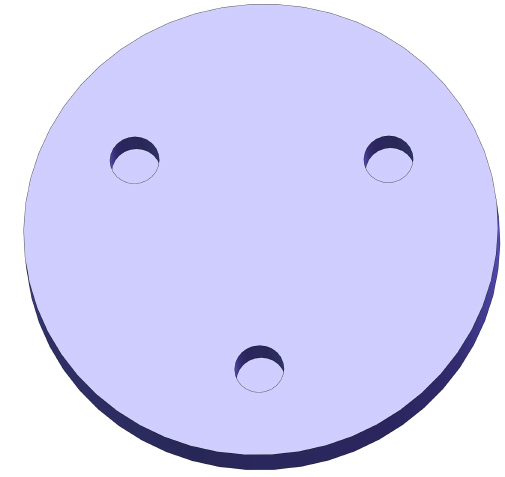
Figure 3. Initial structure of the